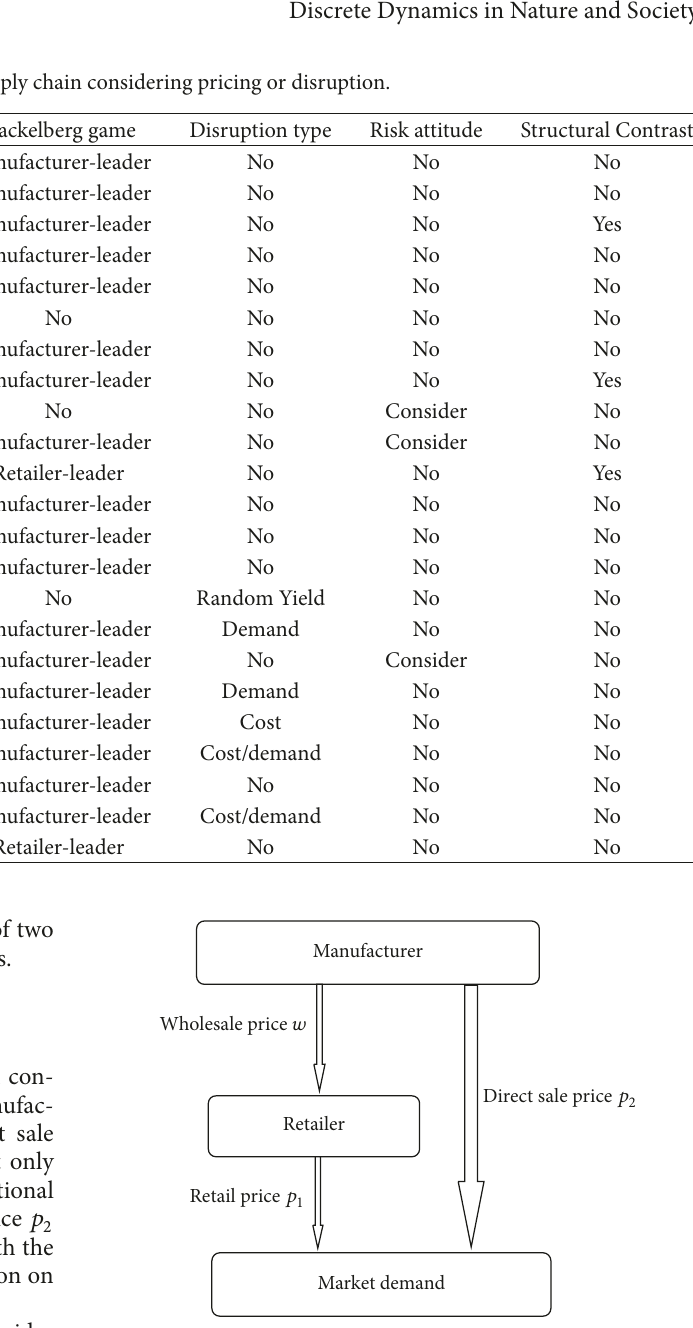
Figure 1: Dual-channel supply chain